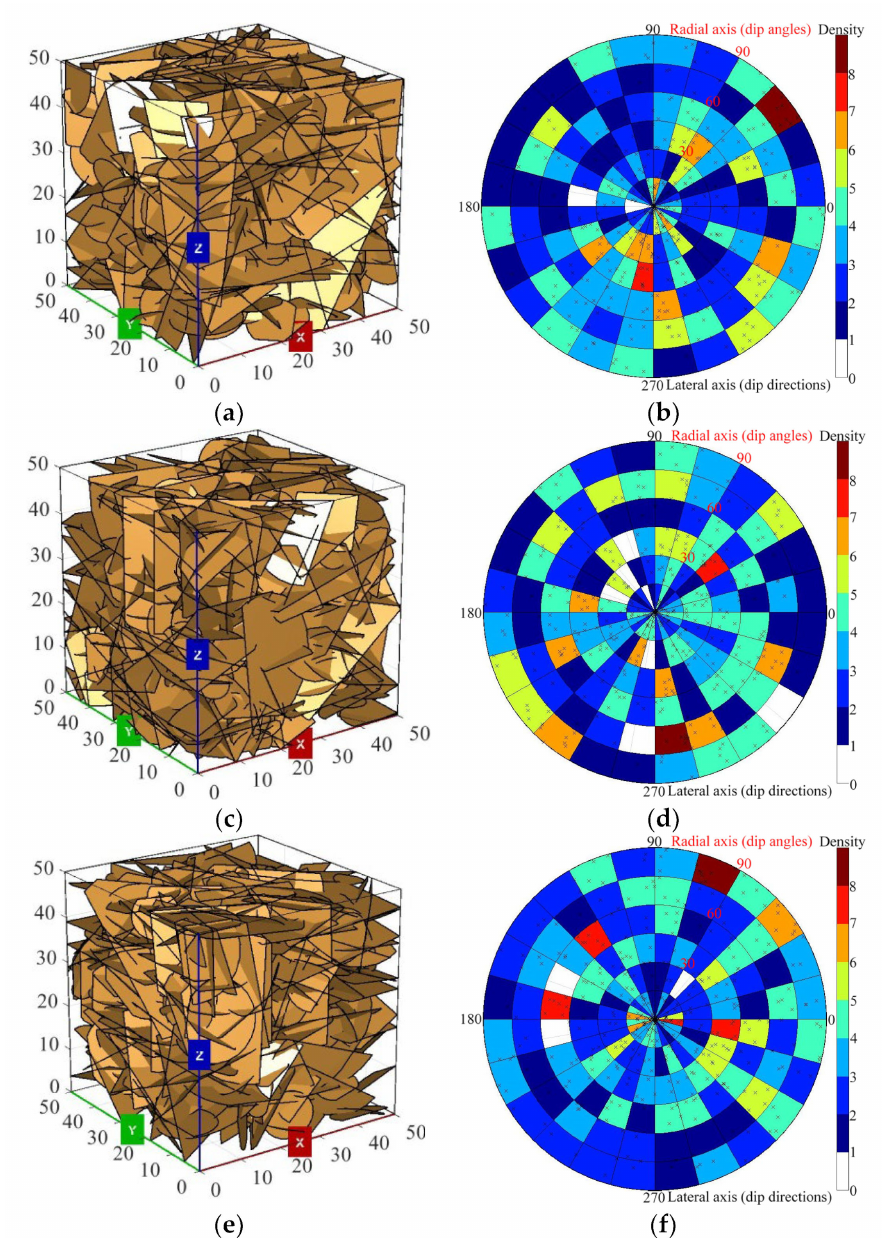
Figure 10. DFN models generated using three sets of random numbers and corresponding stereonet maps of dip directions and dip angles. ( a ) DFN model for set 1; ( b ) Dip directions and dip angles for set 1; ( c ) DFN model for set 2; ( d ) Dip directions and dip angles for set 2; ( e ) DFN model for set 3; ( f ) Dip directions and dip angles for set